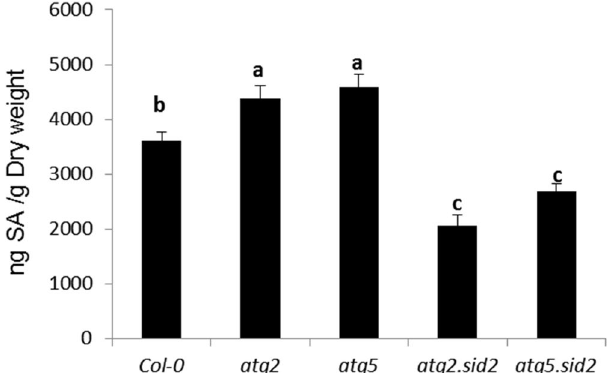
Figure 5. Salicylic acid content in atg mutants: Six week old plants of indicated genotypes were harvested then SA content was monitored as indicated in Materials and Methods. Bars represent standard deviation. N = 10 to 12. Experiments were performed three times with similar results. Different letters in the graph indicate statistical significance between treatments (one-way ANOVA with Tuckey’s test; P <